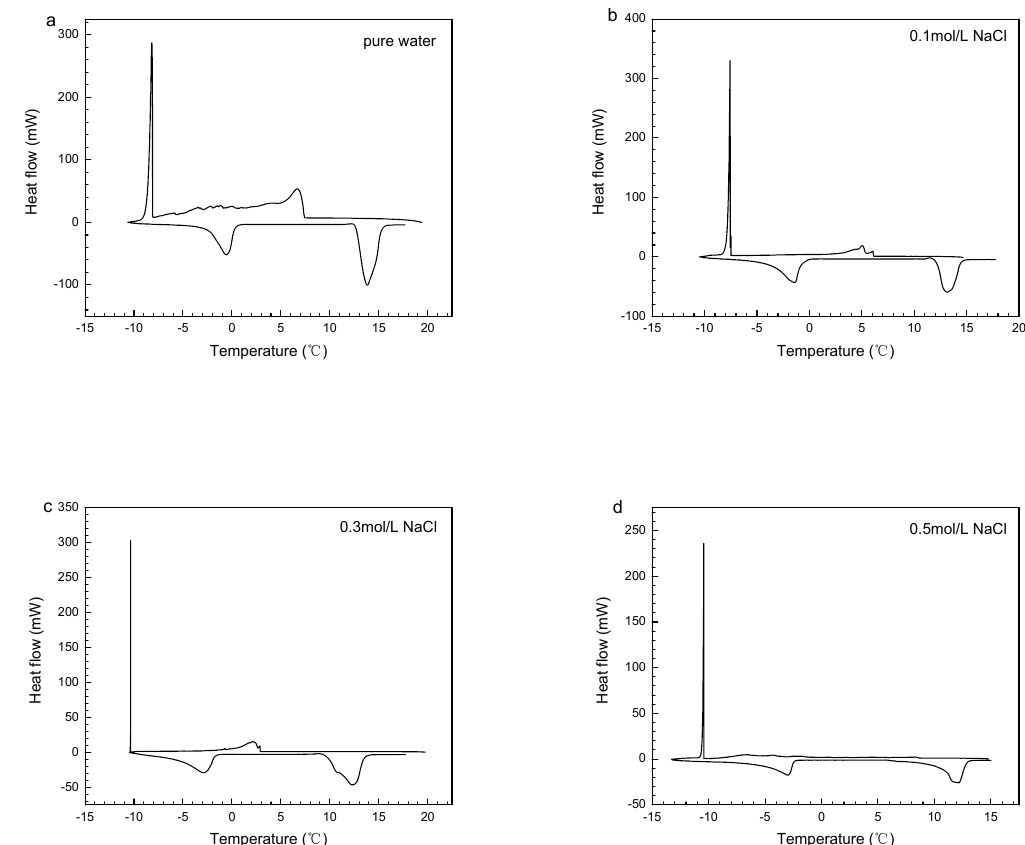
Figure 7. Thermograms of methane hydrate formation and dissociation in montmorillonite samples: ( a ) sample 1, ( b ) sample 2, ( c ) sample 3, and ( d ) sample 4.